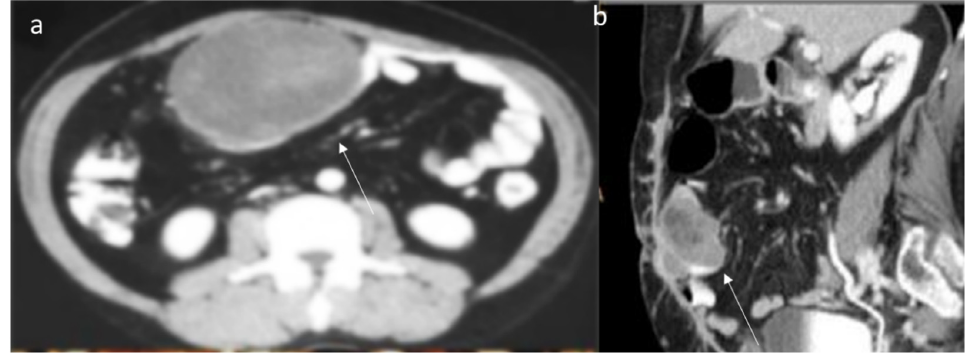
Figure 7. Ileal Gist (arrow) in CT portal phase of contrast study (( a ): axial plane; ( b ): MPR sagittal plane). The lesion shows moderate enhancement with central necrosis.